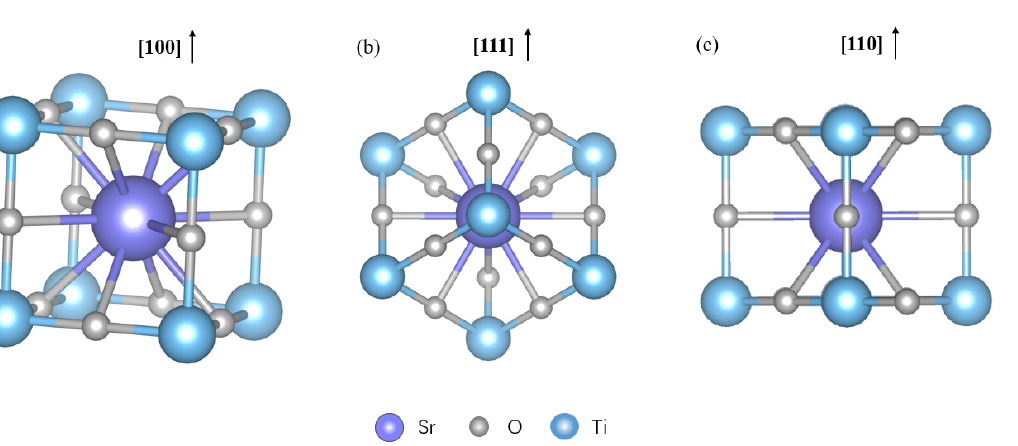
Figure 7. Structural representations of SrTiO 3 , the cubic perovskite structure. The [100] direction is highlighted in ( a ), while ( b , c ) shows a side view of the SrO 3 -terminated [111] and [110] surface, respectively.